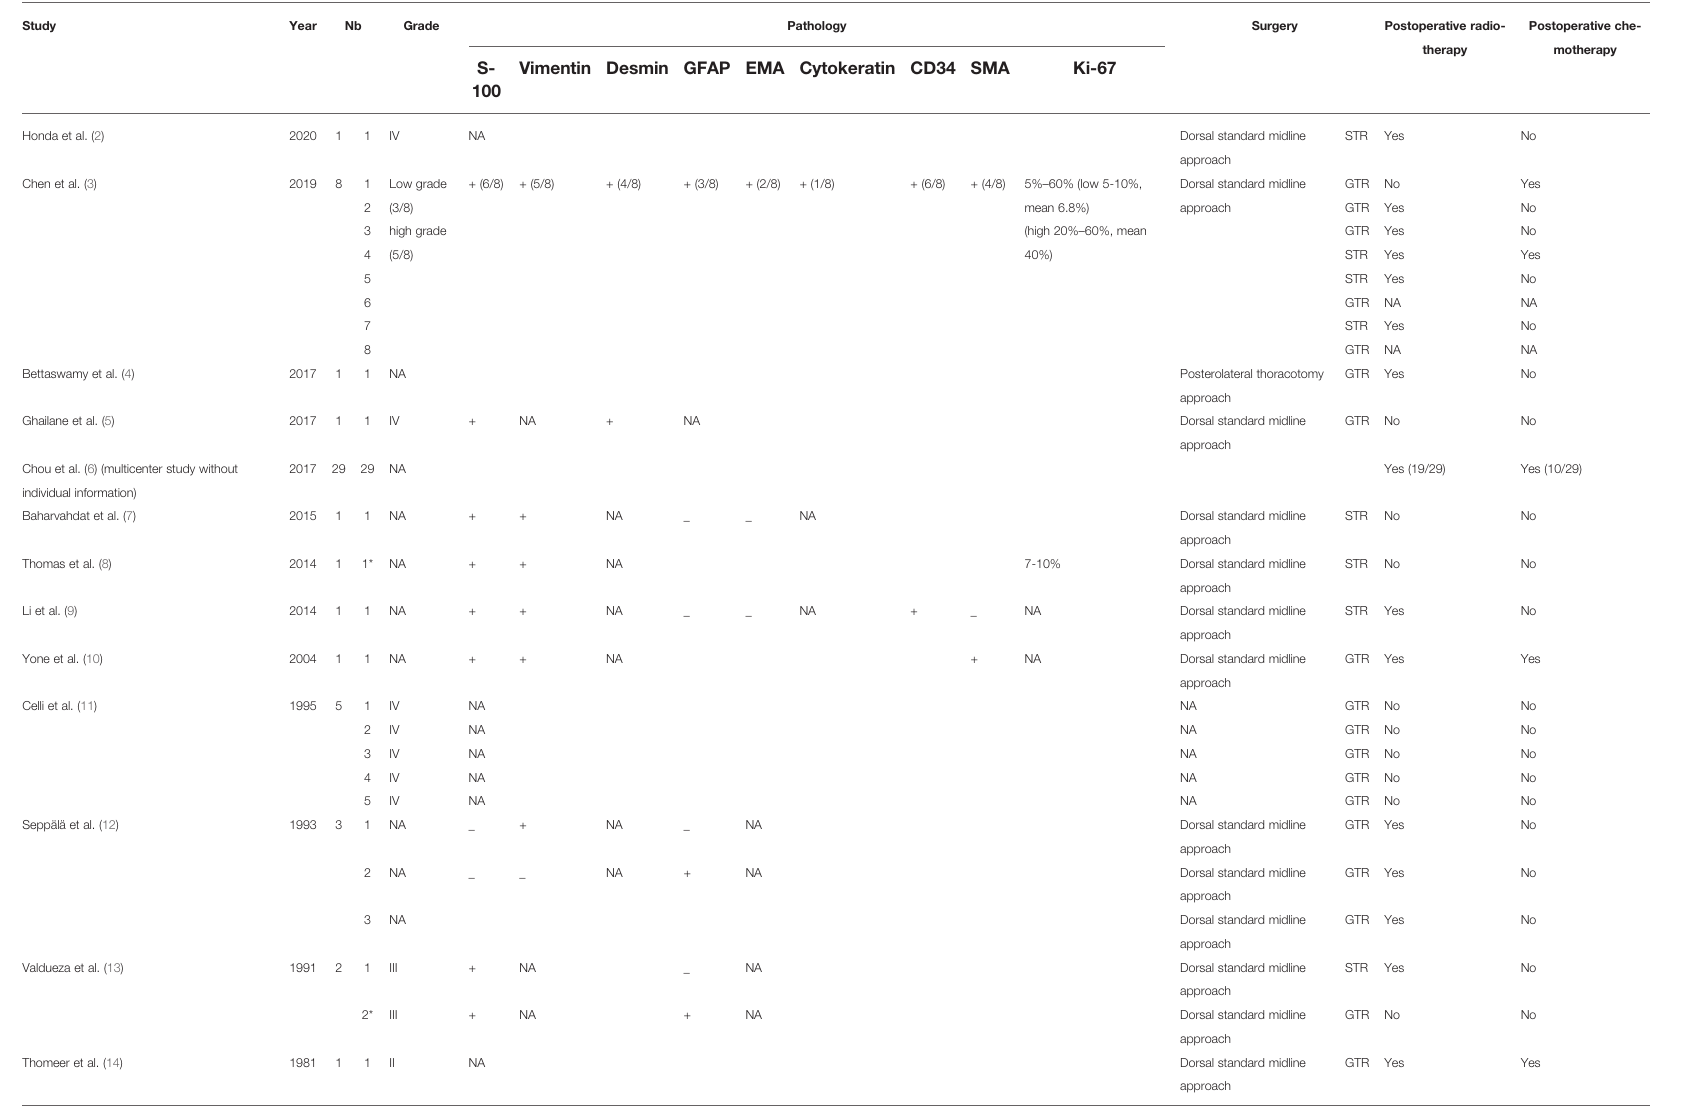
TABLE 2 | The pathological features and therapy of these